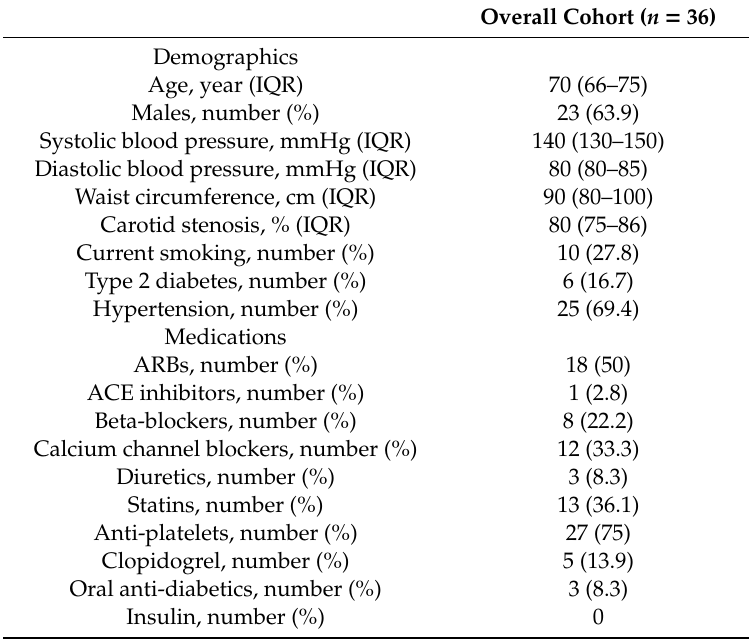
Table 1. Clinical characteristics and medications of the overall cohort